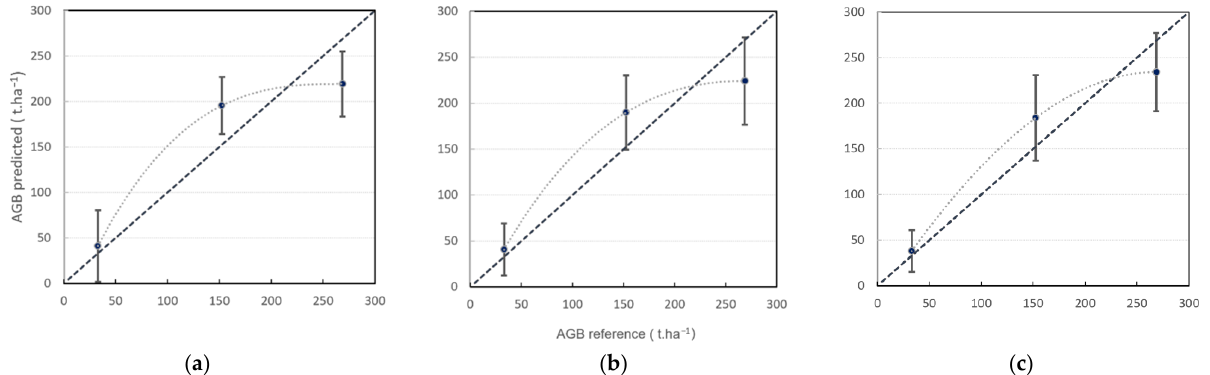
Figure 6. Comparison of the observed and predicted AGB averages per 3 reference AGB ranges for 3 models: ( a ) MR1, ( b ) MPW and ( c ) MR2. Error bars indicate a random error ( σ = SE) of the predicted AGB per reference AGB range. The dotted line indicates a fitting curve to calculated points (3rd order polynomial), and the dashed line corresponds to y = x line. If error bars do not overlap y = x line, bias is the dominant error in that AGB range.